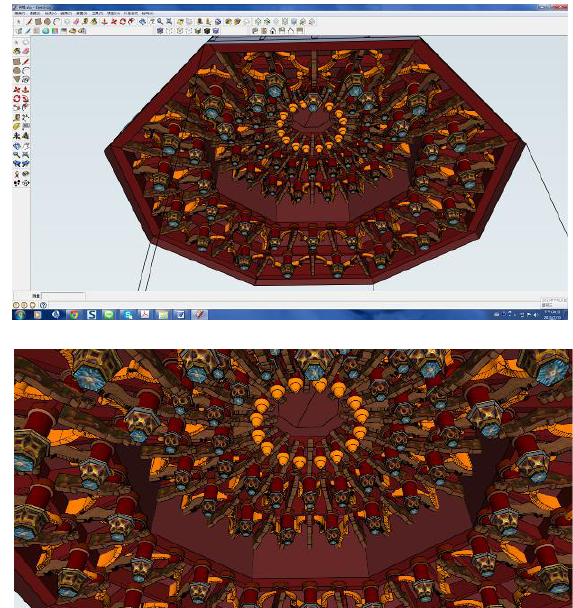
Figure 13. Digitizing Caisson ceiling